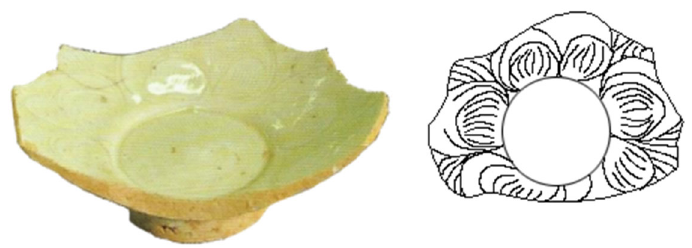
Figure 4. Anatomy of ceramic lotus patterns unearthed from Xiaopi kiln ceramics.